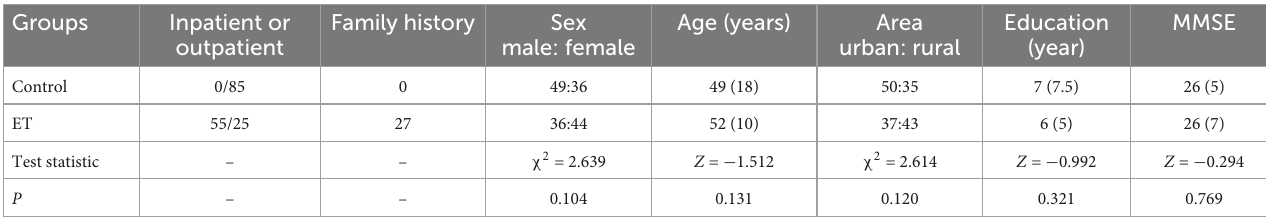
TABLE 1 Demographic characteristics of essential tremor (ET) patients and controls. Groups